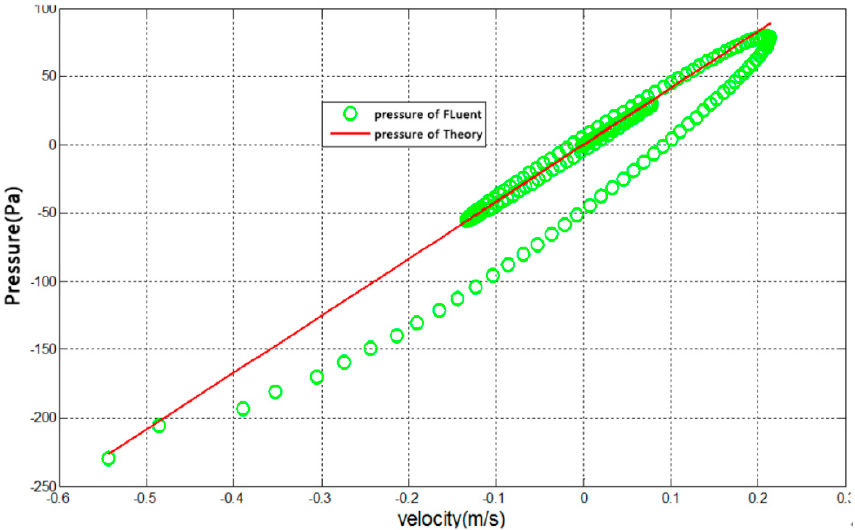
Figure 5. The relationship of velocity and pressure in compressible fluid.